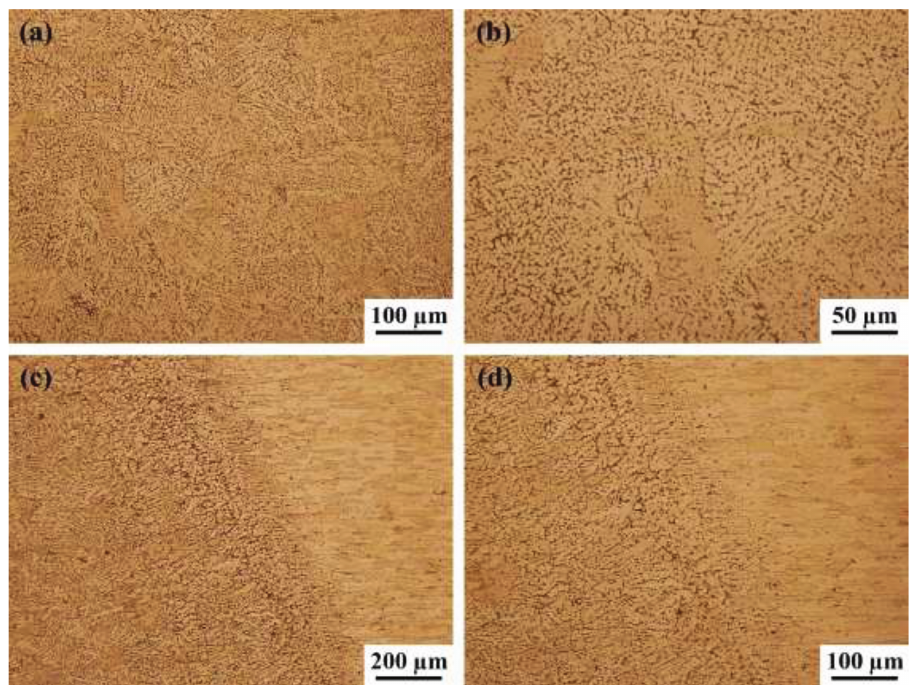
Figure 6: Micrographs of a DWMW A7N01P joint (1200 mm/min): (a) WZ and (b) its high magnification; (c) FZ and (d) its high